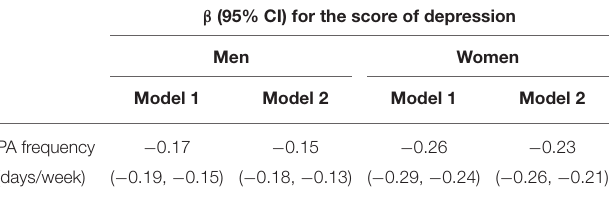
TABLE 3 | Relationship between physical activity and score of depression in 2014. β (95% CI) for the score of depression